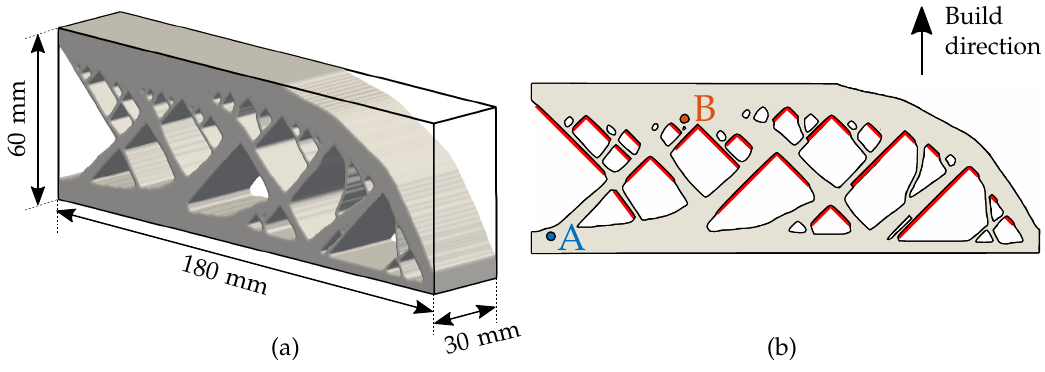
Figure 3. ( a ) The part geometry chosen for analysis with typical LPBF dimensions. ( b ) 2D cross section with overhangs marked with red